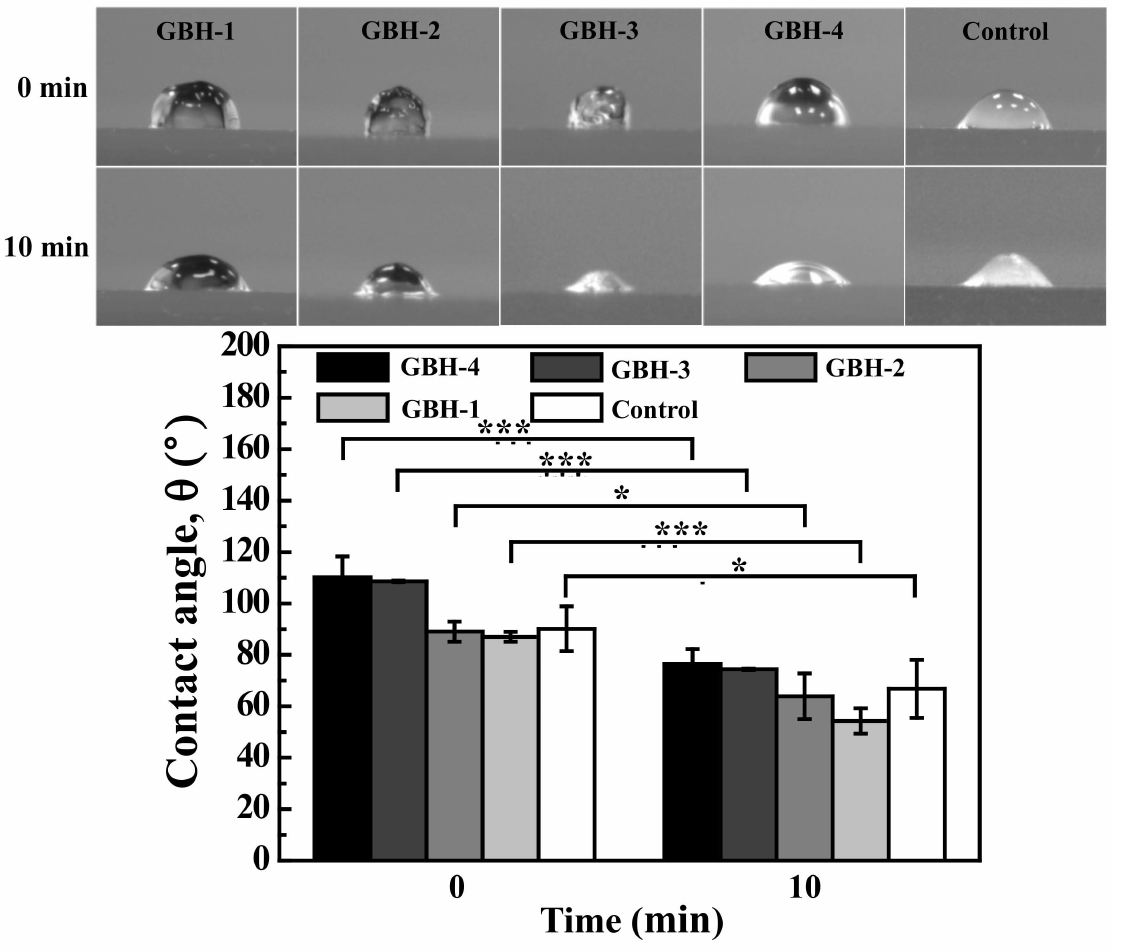
Figure 4. Contact angle results of the investigated hydrogels (* p < 0.05 and *** p <